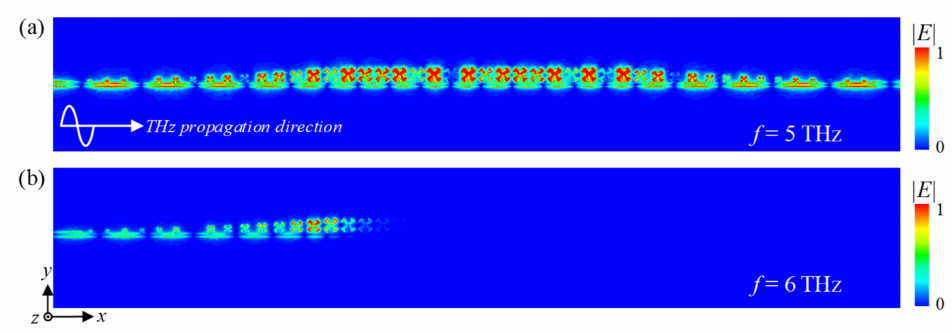
Figure 5. Simulated electric field magnitude (|E|) distributions propagating along the x -direction at ( a ) 5 THz and ( b ) 6 THz on the xoy plane of the terahertz windmill-shaped SSPP